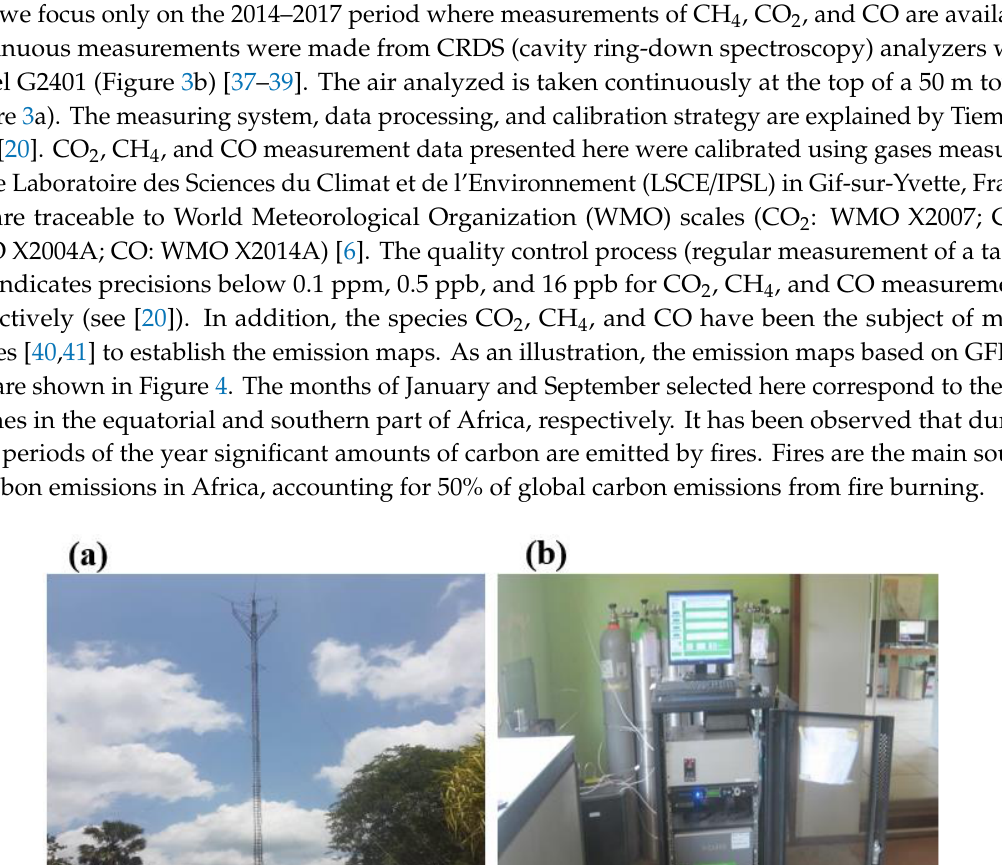
Figure 3. Photo ( a ) of the 50 m high tower and ( b ) of the measurement system “PICARRO G2401”.